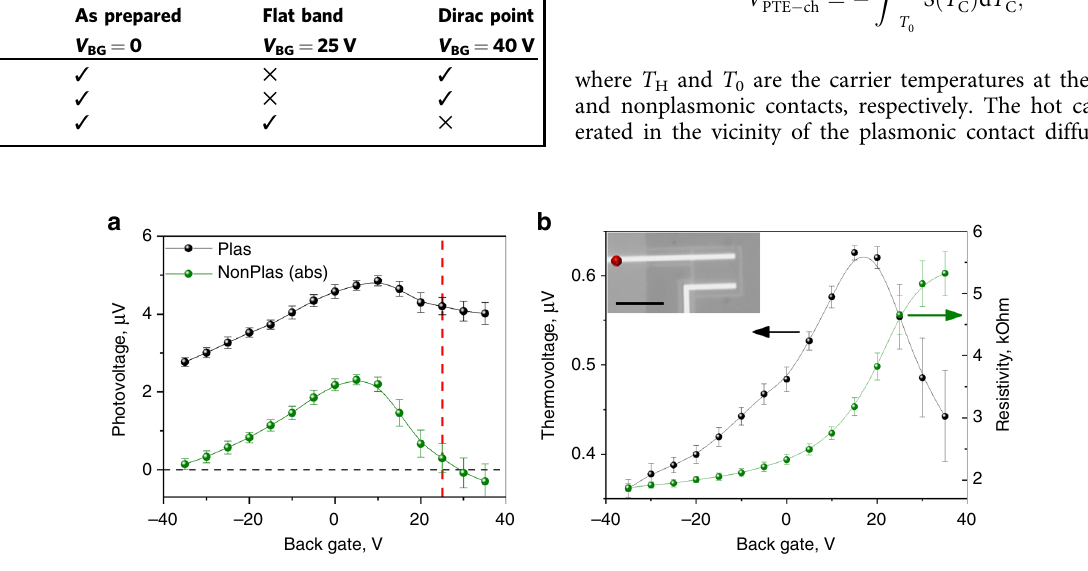
Fig. 4 Gate-dependent photovoltage and thermoelectric response. a The photovoltage response of plasmonic and nonplasmonic (absolute value) contacts. Photovoltage measurements are performed with an elliptical laser spot at 700 nm with 40 µ W power under longitudinal polarization. The vertical dash line represents the fl at-band condition. It should be noted that a direct comparison of the photovoltage generated for the plasmonic and nonplasmonic contacts in terms of absolute values is complicated owing to contact imperfections (Supplementary Discussion 3). b The thermoelectric voltage and square resistance of a representative FET device. Inset: greyscale optical microscopic image of the device with the laser position marked by a red dot. Scale bar is 10 µ m. Measurements are performed with a focussed laser spot at 750 nm and 3 mW power. The error bars are the standard deviation in the measurements